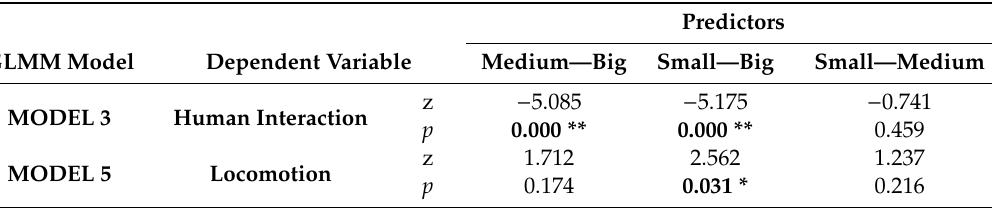
Table 7. Post hoc test for comparison between sub categories of the visitor group size (small, medium, big).